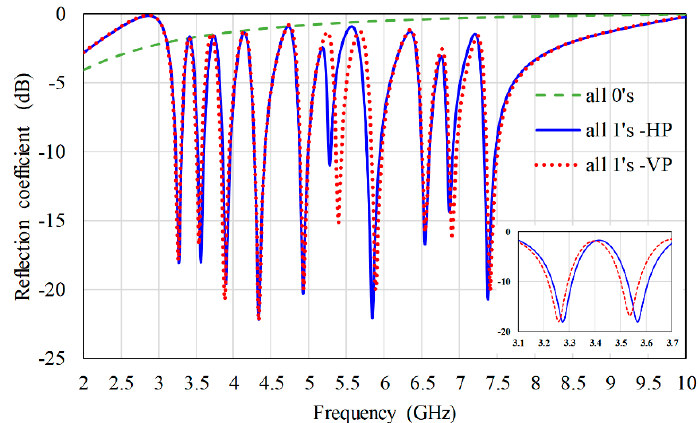
Figure 5. Amplitude reflection coefficients of the vertical (VP) and horizontal (HP) polarizations for states “1111111111” and “0000000000”.